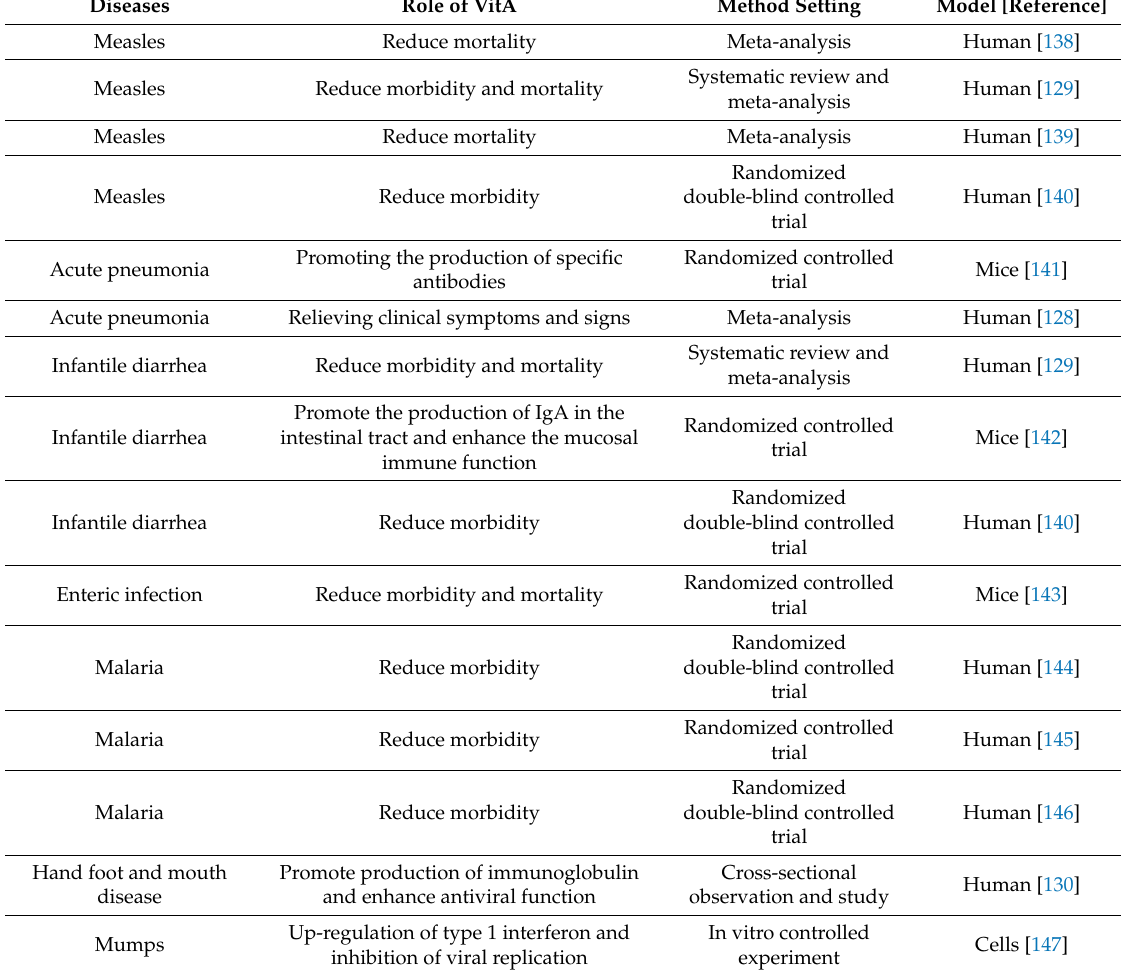
Table 1. The therapeutic effect of VitA on several infantile infectious